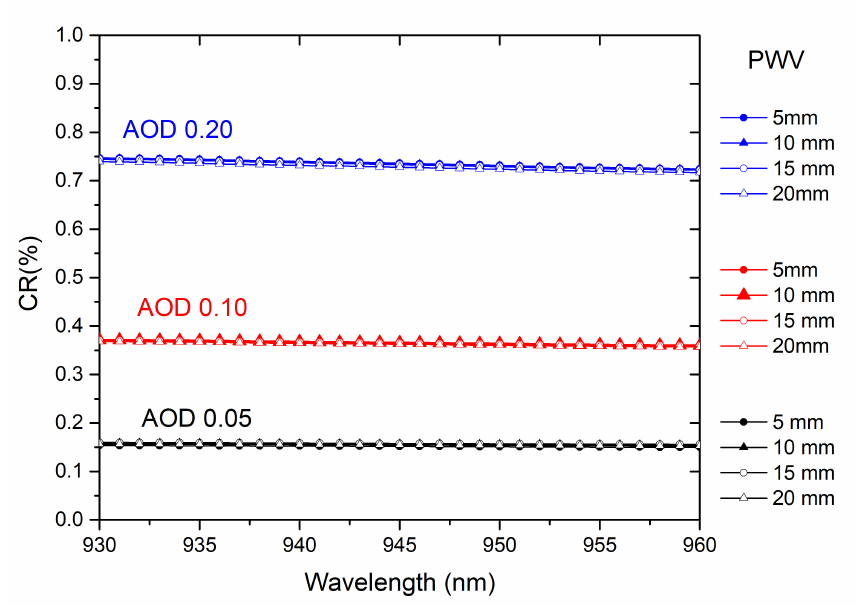
Figure 3. Simulations of CR (%) as a function of wavelength at a SZA of 30º for PWV values of 5, 10, 15 and 20 mm and AOD of 0.05, 0.10 and